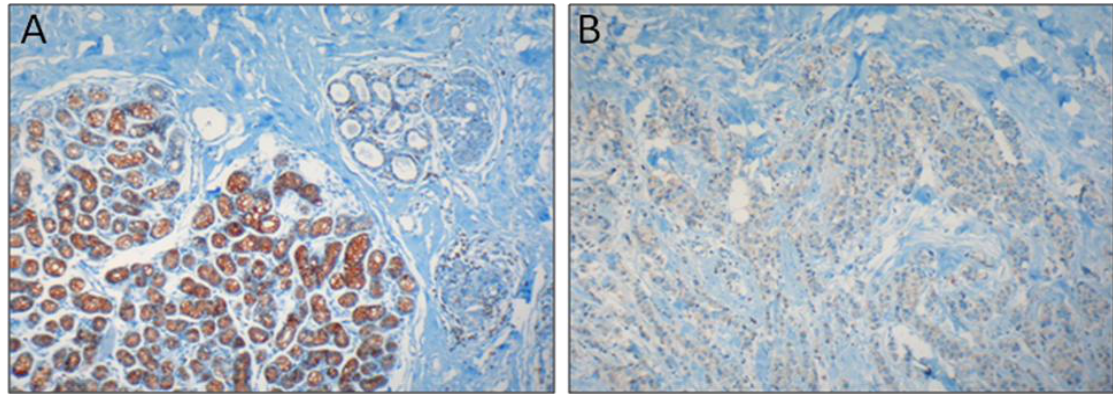
Figure 1. SERCA3 expression in normal breast acini and in invasive lobular breast carcinoma. SERCA3 expression was detected by immunohistochemistry with the avidin-biotin-peroxydase method and 3,3’-diaminobenzidine chromogenic substrate. In normal breast ( A ) strong SERCA3 staining (brown) is observed in the acinar cells of lobules (lower left), and staining of normal ducts is weaker (upper right). When compared to normal acini, SERCA3 expression is markedly decreased in invasive lobular carcinoma ( B ). Tissue was counterstained with hematoxylin